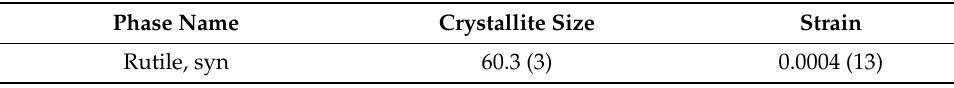
Table 1. XRD results (Rietveld).